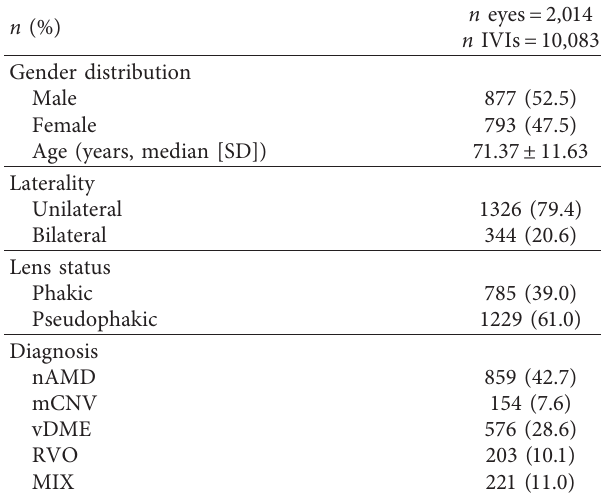
Table 1: Baseline characteristics from 1670 patients.